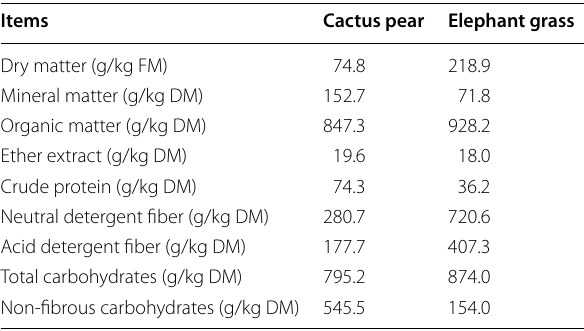
Table 1 Chemical composition of cactus pear and